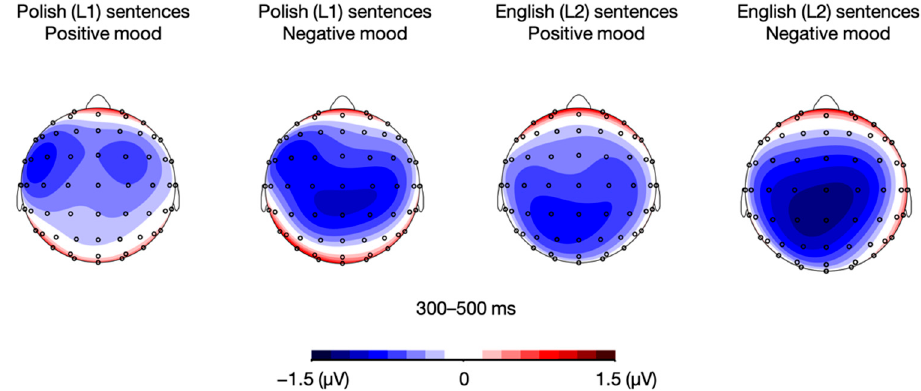
Figure 8. Topographic distribution of the difference between ERP amplitudes in the meaningful and meaningless conditions for Polish (L1) and English (L2) sentences in the positive and negative mood conditions in the 300–500 ms time window.